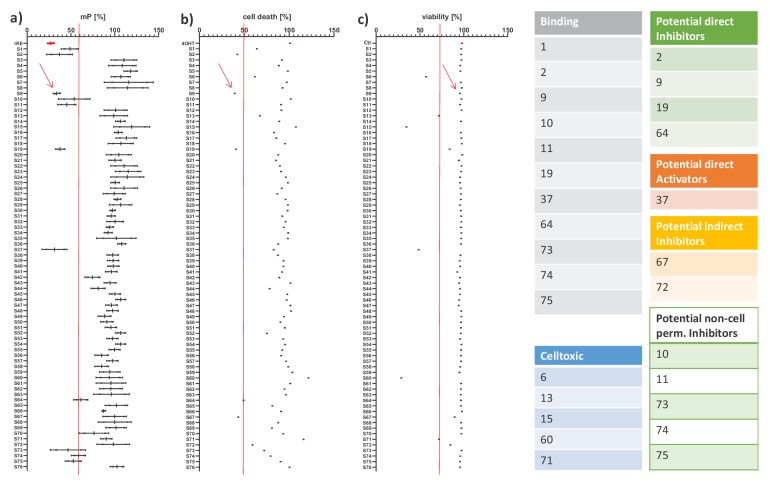
Overview of combined fluorescence polarization assay (FPA)- and live/dead flow cytometry-based validation of candidate compounds.FPAs were performed with 125 nM FOXO3-DBD and 25 nM FAM-labeled IRE-oligonucleotide as described in Materials and methods. Compound concentration was 1 μM. mP value of freely rotating IRE-FAM oligonucleotide was subtracted. Threshold for FPA was set to 60% mP value reduction (a). For flow cytometry, SH-EP/FOXO3 cells were treated with 20 nM 4OHT and 20 μM of each compound for 48 hours. Apoptotic cells were detected using propidium-iodide staining of fragmented nuclei. Threshold for cell death inhibition was set to 50% of FOXO3-induced cell death (b), threshold for viability/toxicity was set to 75% of DMSO- treated controls (c). From those compounds that reduced mP in the FPA, S2, S9, S19, and S64 demonstrated a clear death-inhibitory effect in the conditional FOXO3 system suggesting that these are 'Potential direct inhibitors' of FOXO3, S37 induced cell death and triggered FOXO subcellular shuttling (data not shown) suggesting that this compound triggers FOXO3 activation ('Direct activator'). Compounds not affecting cellular FOXO3 effects (S10, S11, S73, S74, S75) despite mP reduction in the FPA apparently do not transit the cytoplasm membrane. Compounds S67 and S72 did not demonstrate significant effects in the FPA, but inhibited cell death induction by ectopic FOXO3, suggesting that these compounds rather inhibit FOXO3-induced cell death indirectly in this system ('Indirect inhibitors').